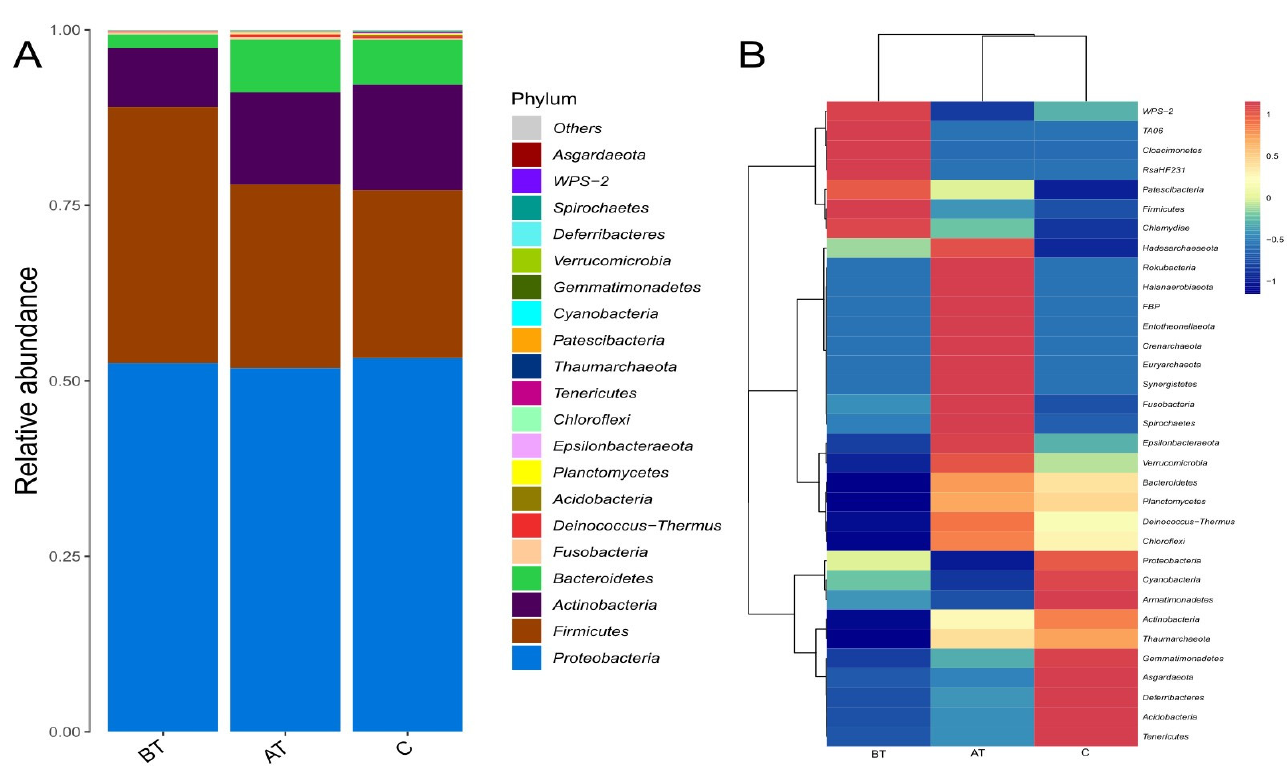
Figure 3. Relative abundance of facial microbiota at phylum level among the pre-treated (BT), treated (AT), and (C) acne groups ( A ): Barplot presenting mean relative abundance in terms of percentage among the three experimental groups. ( B ): The correlation heatmap presents relative abundance in percentage among the three experimental groups at the phylum level.